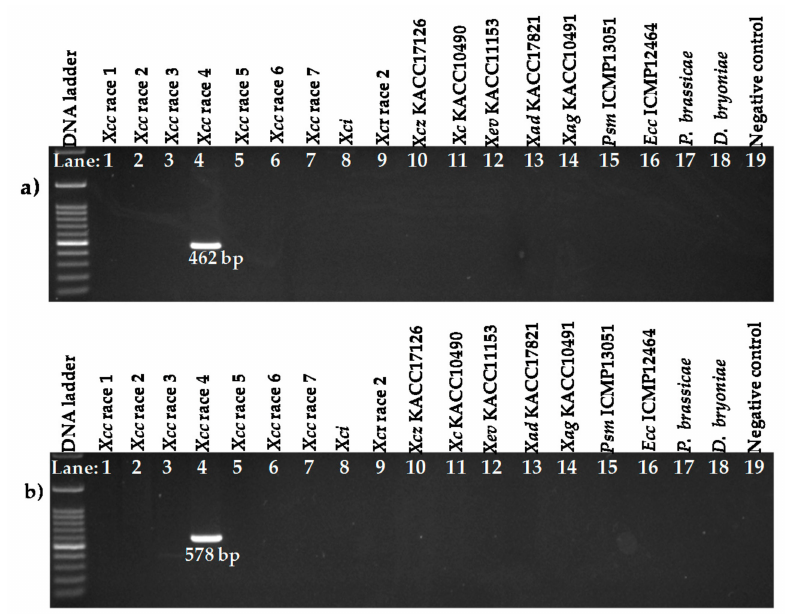
Figure 4. Agarose gel electrophoresis of Sequence Characterized Amplified Regions (SCAR) PCR products from genomic DNA of X. campestris pv. campestris races and X. campestris pathovars and other bacteria and protist. Reactions were performed using the primer pairs ( a ) Xcc1_46R4_F, Xcc1_46R4_R and ( b ) Xcc2_46R4_F, Xcc2_46R4_R. DNA ladder-100 bp; Lanes 1–7: Xcc race 1 to race 7; Lane 8: WHRI-6377 ( Xci ); Lane 9: WHRI-8305 ( Xcr ); Lane 10: Xcz (KACC17126); Lane 11: Xc (KACC10490); Lane 12: Xev (KACC11153); Lane 13: Xad (KACC17821); Lane 14: Xag (KACC10491); Lane 15: Pseudomonas syringae pv. maculicola (ICMP13051); Lane 16: Erwinia carotovora subsp.